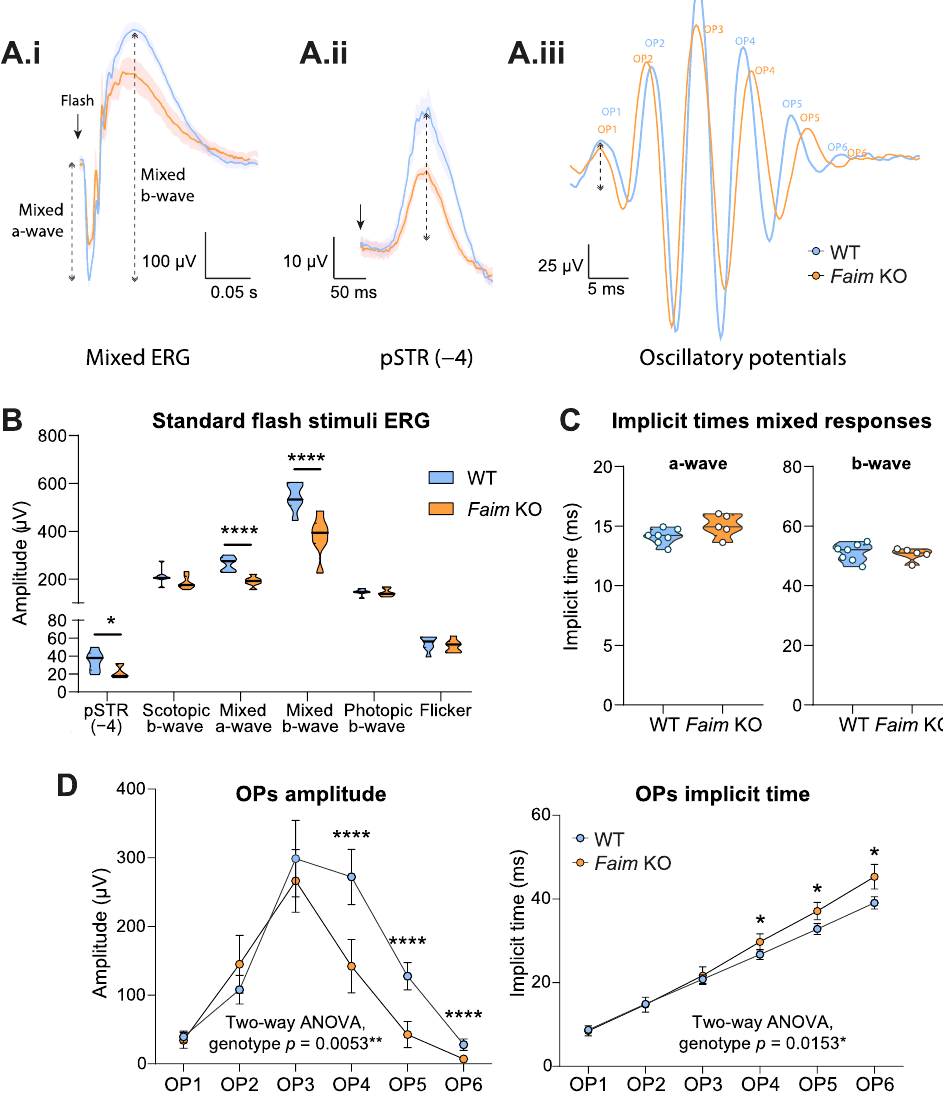
Figure 1. Photoreceptor and RGCs responses are altered in Faim knockout (KO) mice at 18 months. ( A ) Electroretinogram (ERG) recordings of mixed a- and b-wave responses at 1.5 log cd·s/m 2 ( A.i ), positive scotopic threshold response (pSTR) ( − 4 log cd·s/m 2 ) ( A.ii ), and representative oscillatory potentials (OPs) from each genotype ( A.iii ). ( A.i , A.ii ) data are plotted as the mean (solid line) and SEM deviation (shaded area) of each condition. Bold arrows indicate the stimulus flash. ( B ) Summary of ERG analysis of pSTR representing retinal ganglion cell (RGC) response, scotopic b-wave representing rod bipolar response, mixed a- and b-waves mainly representing rod responses and photopic b-wave and flicker (20 Hz) representing cone responses. To summarize, data were plotted together in B as violin plots. ( C ) Implicit times of the mixed a- and b-waves graphed as violin plots. Student’s t test was performed. ( D ) Summary of the amplitudes and implicit times recorded on ERG of the OPs. OP4-6 are considered to be linked to amacrine and RGC responses. Data in B and C are plotted as violin plots, in which the median is represented by a thick line. Data in D are represented as means and SD (n = 7–14 mice/group). Multiple Student’s t test and Student’s t test were performed between genotypes in B and C, and Two-way ANOVA and Sidak’s post-hoc test were performed in D. * p < 0.05, ** p < 0.01, **** p <